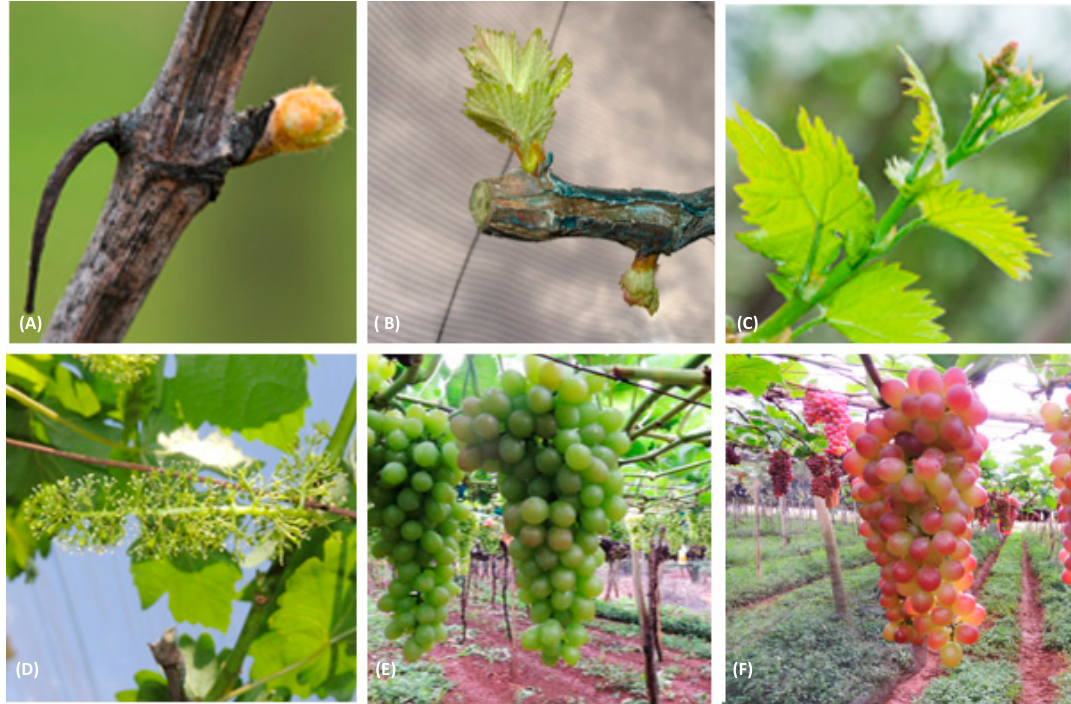
Figure 1. Phenological phases of ‘BRS Melodia’ seedless grape. ( A ) Bud-swell; ( B ) sprouting or budburst; ( C ) emergence of the inflorescence; ( D ) flowering; ( E ) véraison; ( F ) harvest or full ripe.